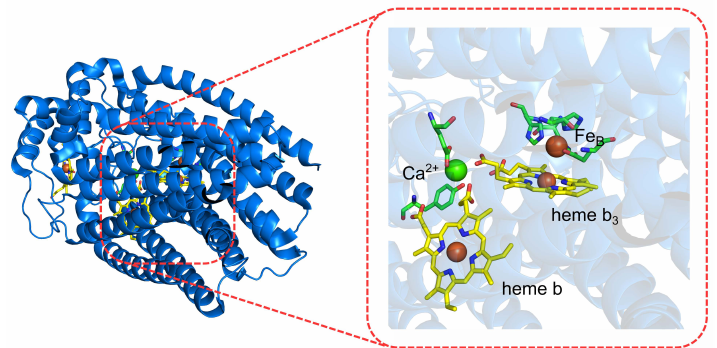
Figure 7. Active site ( right ) of nitric-oxide reductase ( left ) obtained from Pseudomonas aeruginosa (PDB: